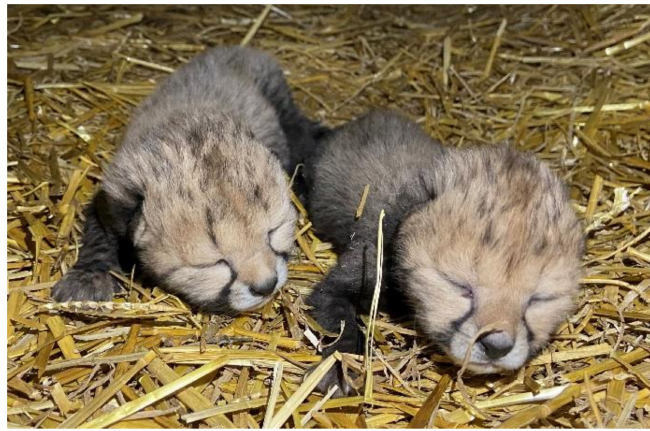
Figure 4. Cheetah cubs 2 days after birth.